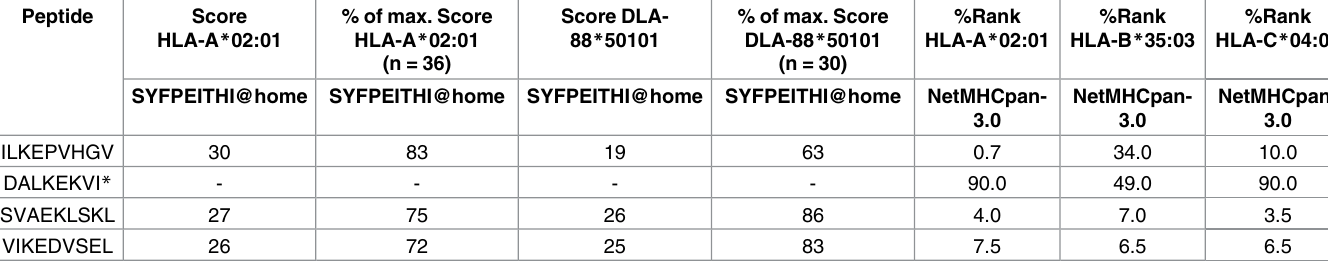
Peptides used for binding analysis of HLA-A2 derived peptides into DLA (ILKEPVHGV, DALKEKVI, University of Tuebingen). Scores for peptides deriving from DLA-88 * 50101 selected for peptide synthesis (SVAEKLSKL, VIKEDVSEL, University of Tuebingen) and subsequent peptide binding analysis. * For HLA-A * 02:01, there is no matrix availablefor octamers with reference to SYFPEITHI@home.